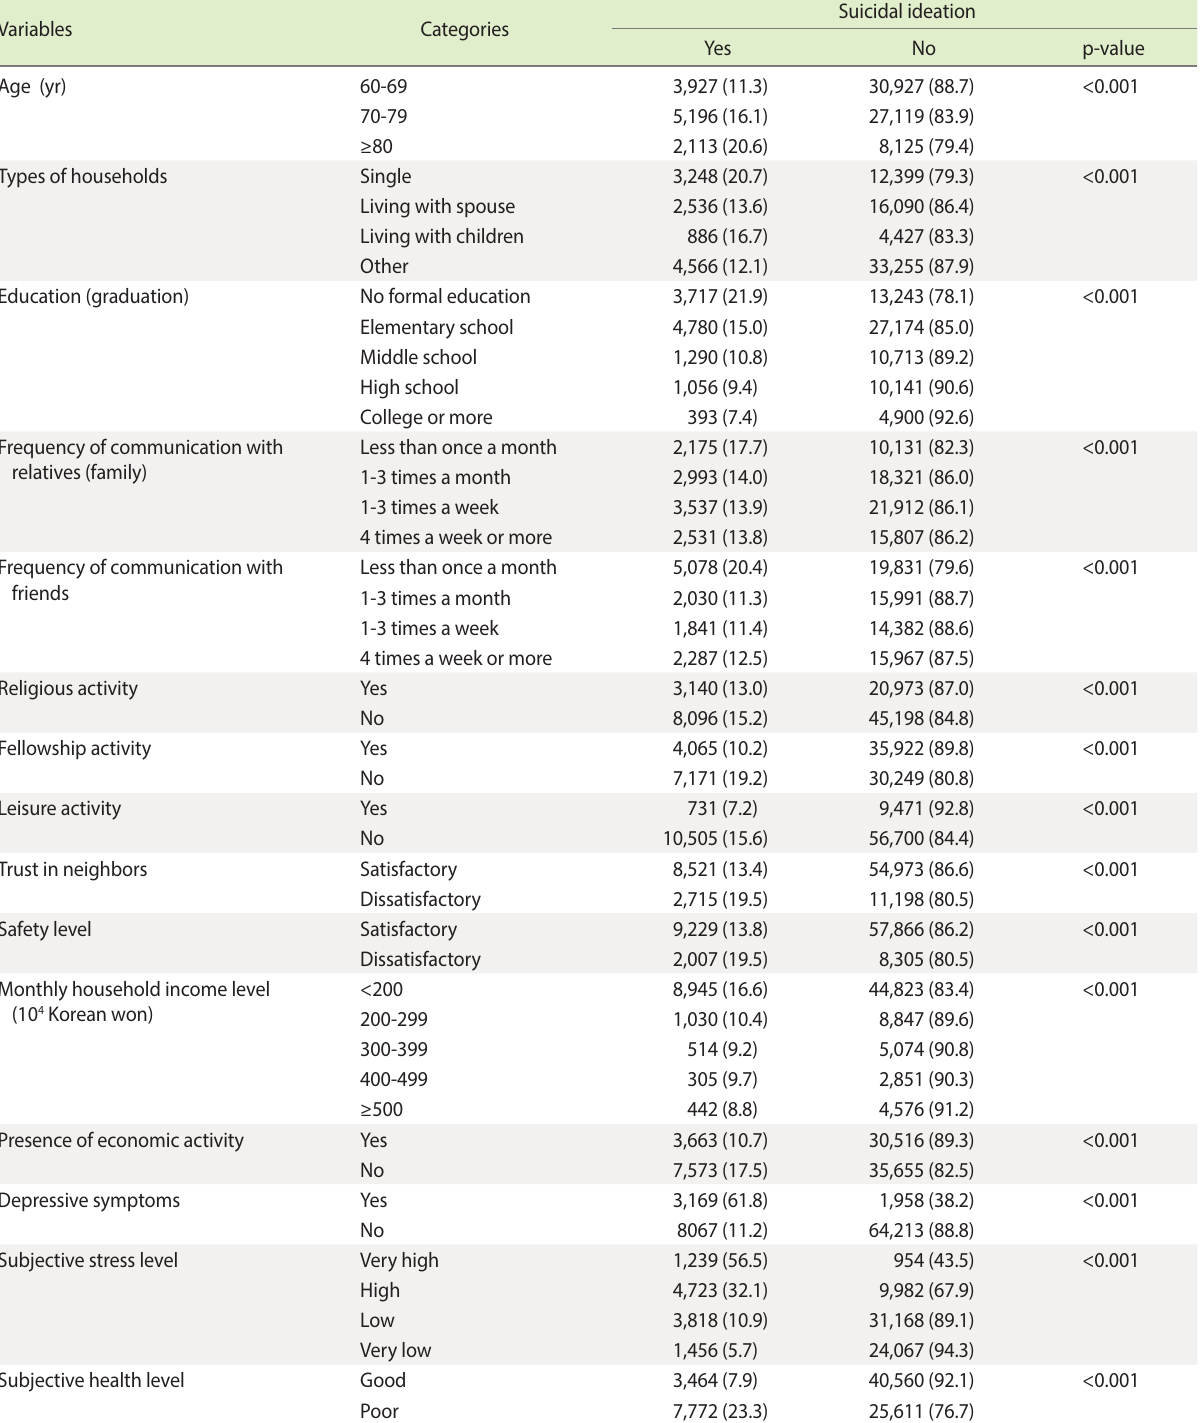
Table 1. Socio-demographic characteristics of the study subjects and suicidal ideation by group